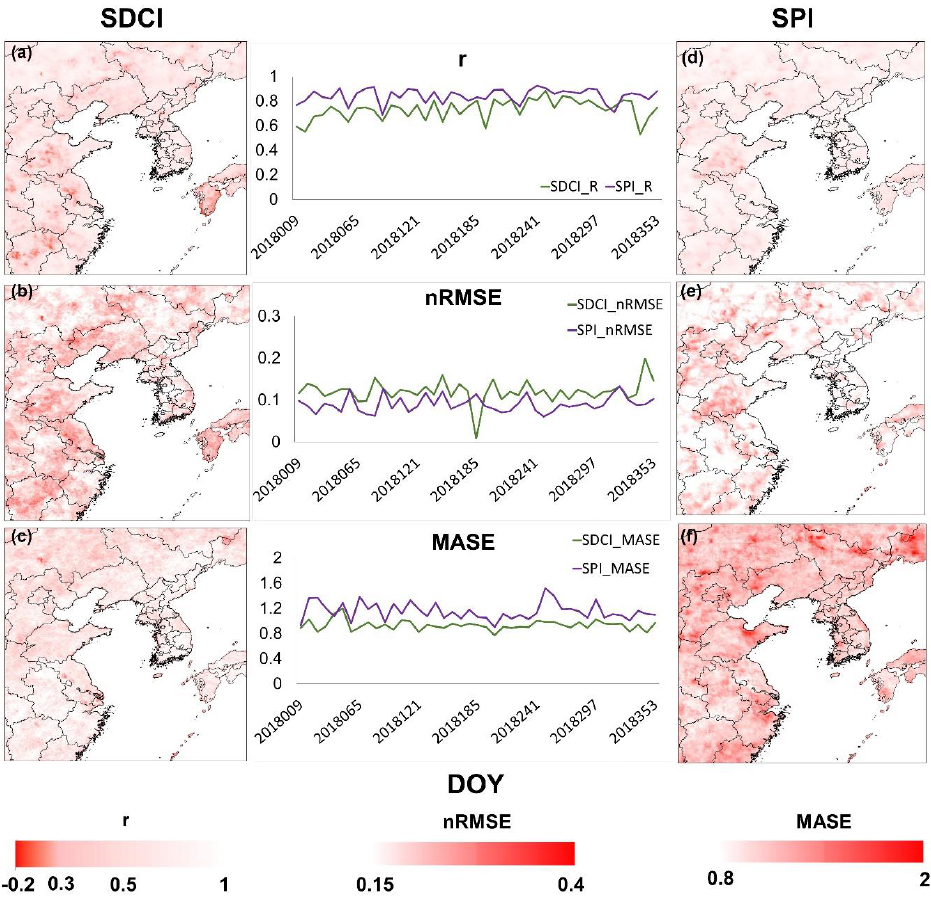
Figure 6. Spatial distribution and time-series patterns of r, nRMSE, and MASE from random forest model results for SDCI and SPI. The vivid red in the six maps indicates areas of relatively high errors ( a–f ). The green and purple in three time-series graphs indicate the time-series patterns of SDCI and SPI, respectively.